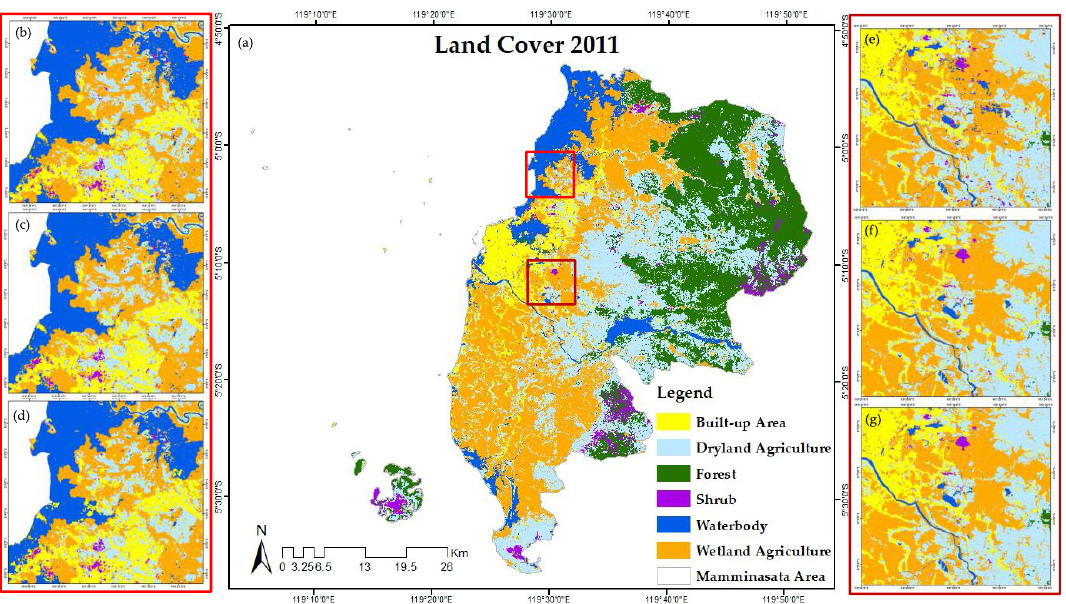
Figure 5. Land cover classification: ( a , c , f ) 2011 using a support vector machine (SVM) classifier; ( b , e ) 2006 using change detection; and ( d , g ) 2016 using change